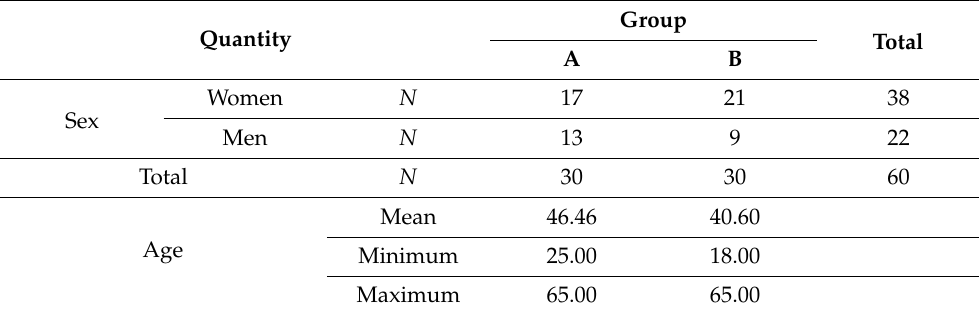
Table 1. The description of the study